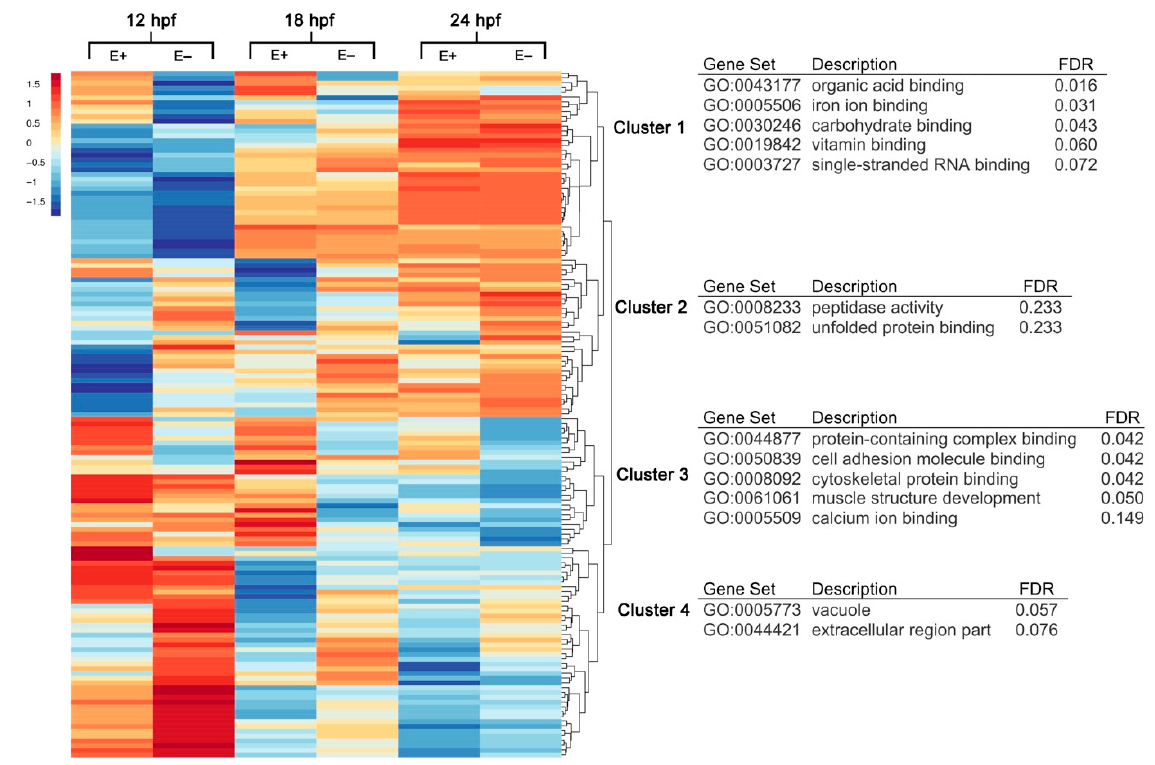
Figure 1. Hierarchical clustering and gene annotation of differentially expressed genes in E– and E+ embryos at 12, 18 and 24 hpf. Heatmap of all differentially expressed (DE) genes ( n = 286, FDR < 0.1) clustered with z -score averages according to VitE status, age and gene with red color indicating greater expression relative to all-condition average and blue color indicating lower expression relative to all-condition average amongst all expression values (rows correspond to genes, columns correspond to conditions). Clusters within heatmap annotated by Gene Ontology (GO) terms organized by Benjamini–Hochberg False Discovery Rate (FDR).